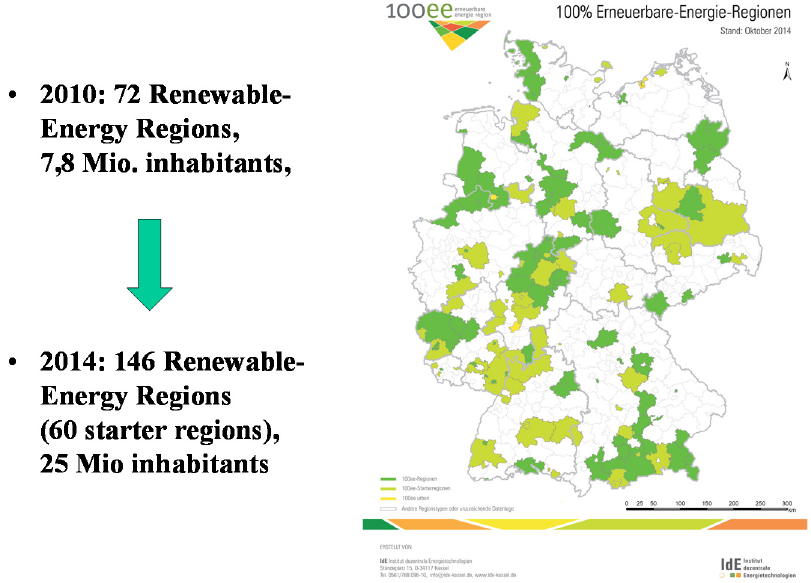
Figure 6. “100%-Renewable-Energy” Regions in Germany 2014 (2010) (Umwelt 12/2012, IdE